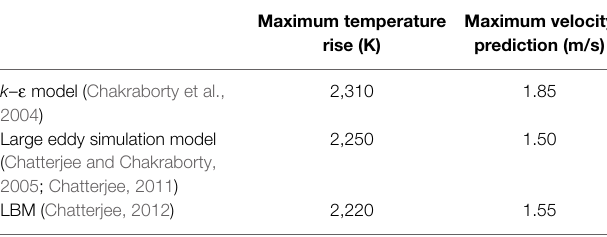
TABLE 2 | Comparison from various models